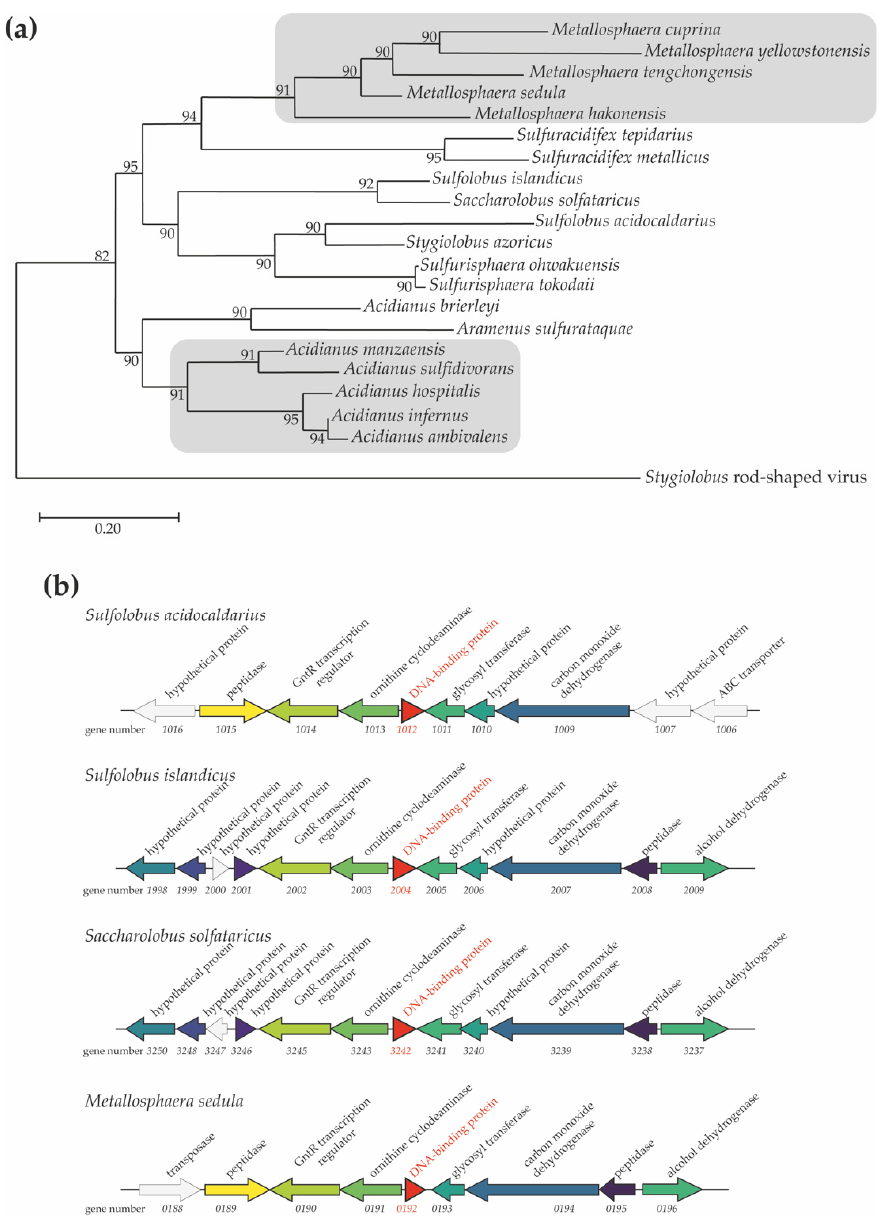
Figure 1. Phylogenetic occurrence of Sul12a. ( a ) Phylogenetic tree of Sul12a homologs based on a clustal omega alignment. The scale bar refers to the number of nucleotide substitutions per site, representing the phylogenetic distance. ( b ) Genome organization of Sul12a -like genes (indicated in red as DNA-binding protein) in selected species of Sulfolobales. Predicted gene functions are mentioned based on annotations [15]. Colors refer to orthologous genes.